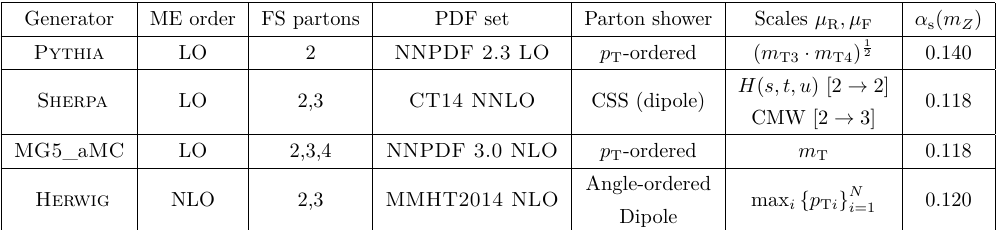
Table 1 . Properties of the Monte Carlo samples used in the analysis, including the perturbative order in α s , the number of final-state partons, the PDF set, the parton shower algorithm, the renormalisation and factorisation scales and the value of α s ( m Z ) for the matrix